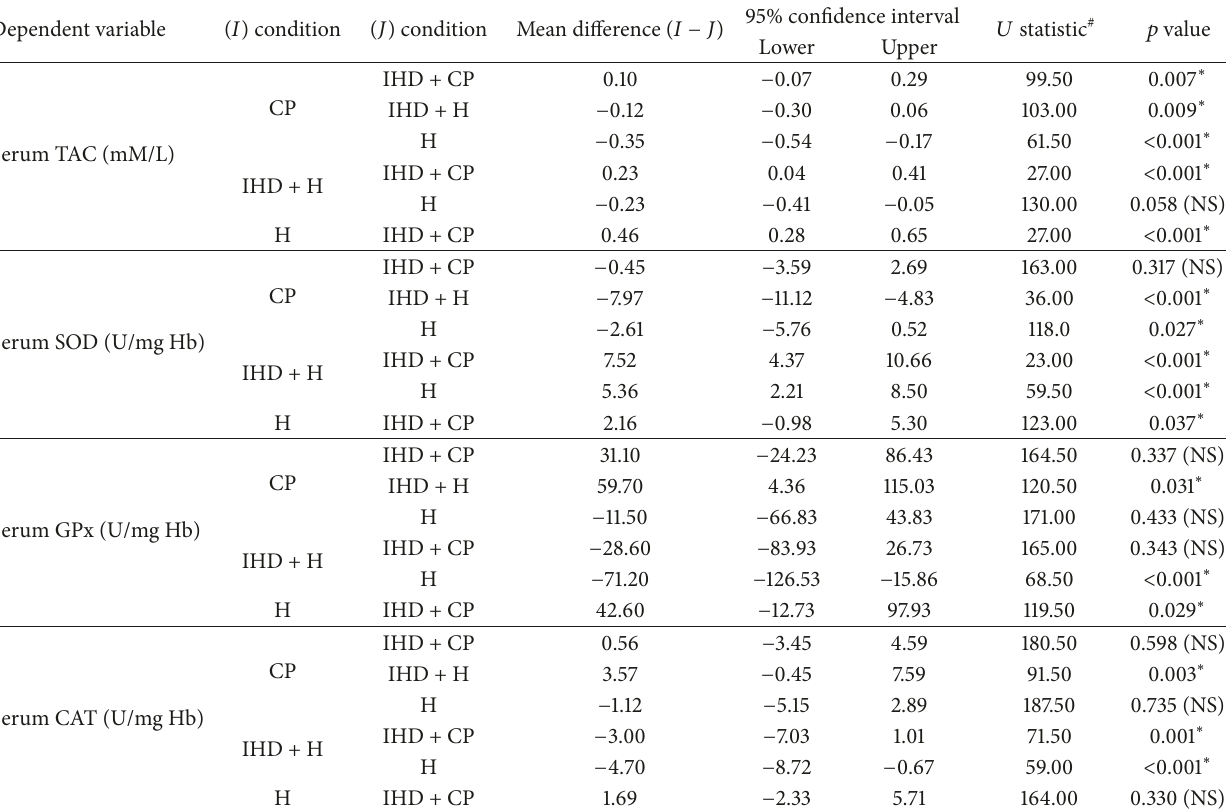
Table 2: Pairwise comparison using Mann–Whitney 𝑈 test